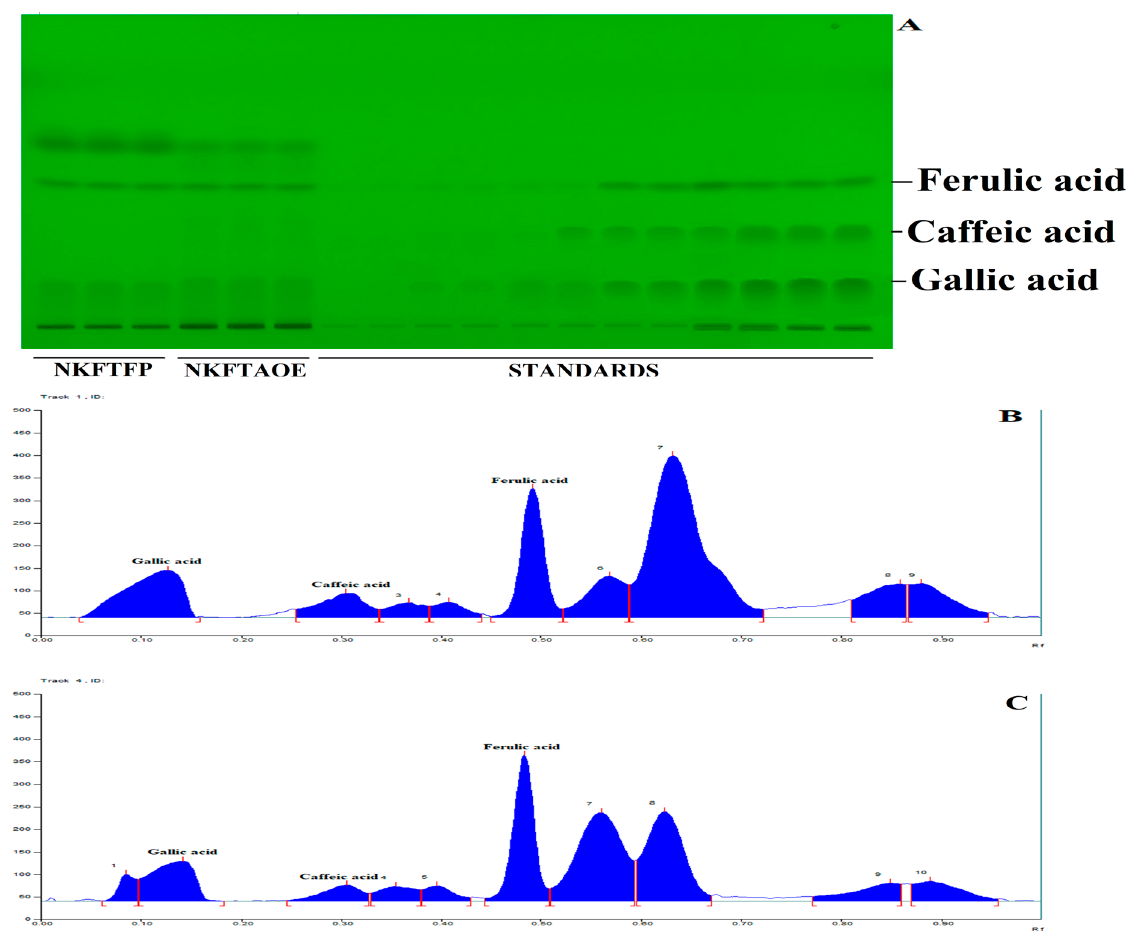
Figure 2. HPTLC profile of NEERI KFT, ( A ) represents the HPTLC developed plate at 254 nm, ( B , C ) show HPTLC chromatograms for NKFTFP and NKFTAQE at 260 nm, respectively.